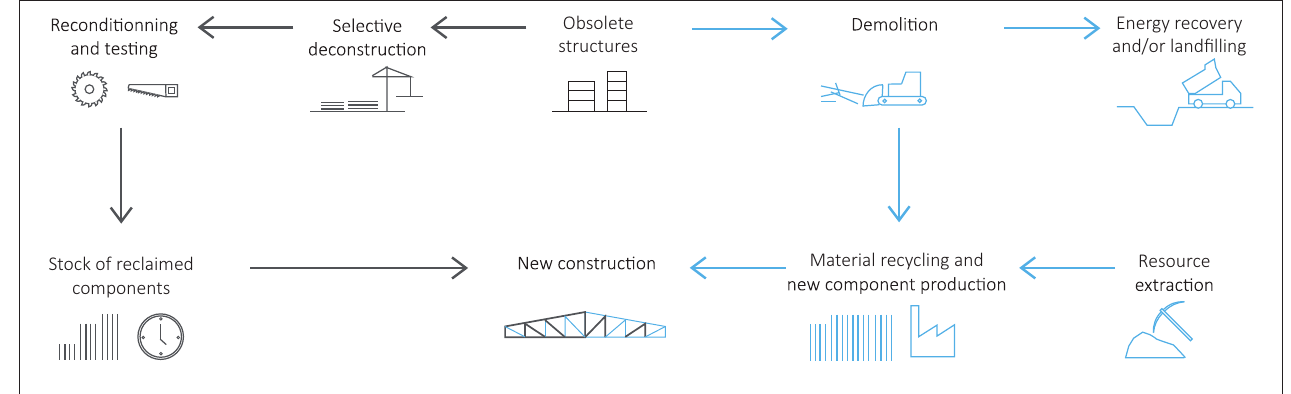
FIGURE 1 | Supply-chains of reused (dark gray) and new (blue)